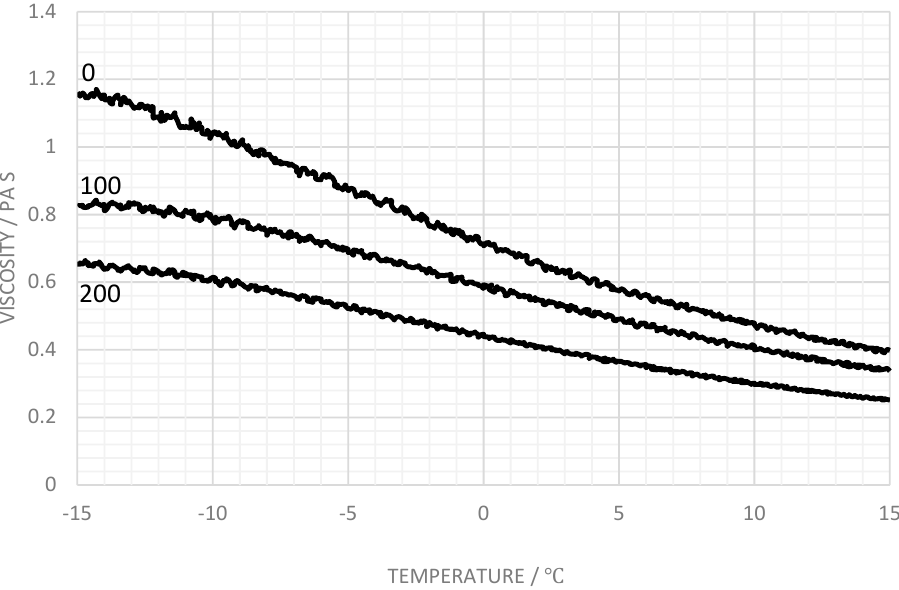
Figure 5. Viscosity variation for the 75 wt% Carbomer A solution containing 50 mg L − 1 Ca 2 + with additions of 0, 100, and 200 mg L − 1 Na + at a shear stress of 5 Pa.